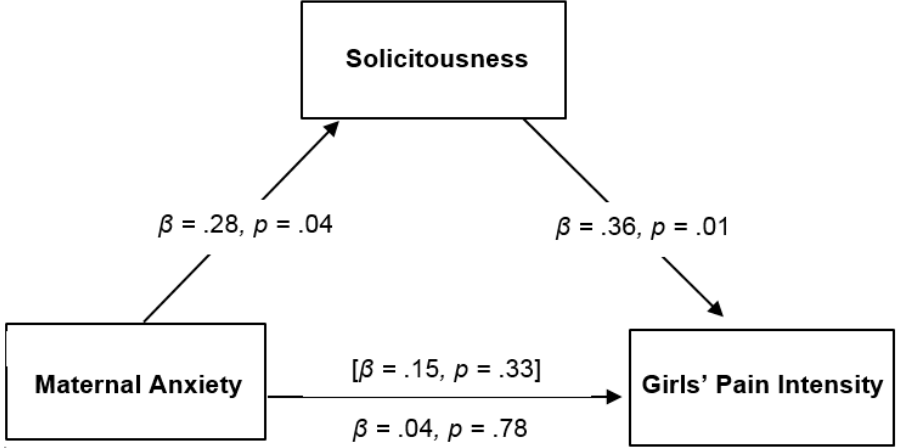
Figure 3. Mediating role of solicitousness in the relation of maternal anxiety with girls’ lab pain intensity. Estimates of total effect of maternal anxiety on girls’ pain outcomes are presented in brackets, with values representing estimates of the total indirect effect of maternal anxiety on girls’ pain outcomes through maternal solicitousness presented below.